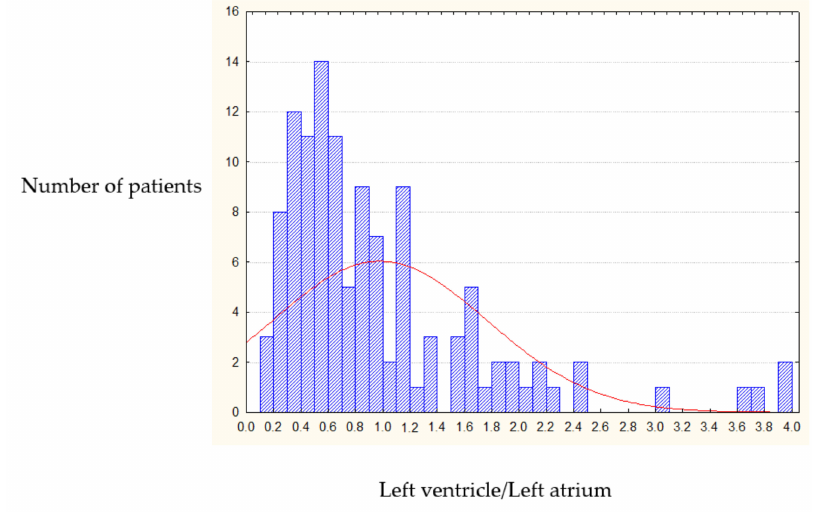
Figure 2. Pre-operative IRV distribution (left heart chambers).